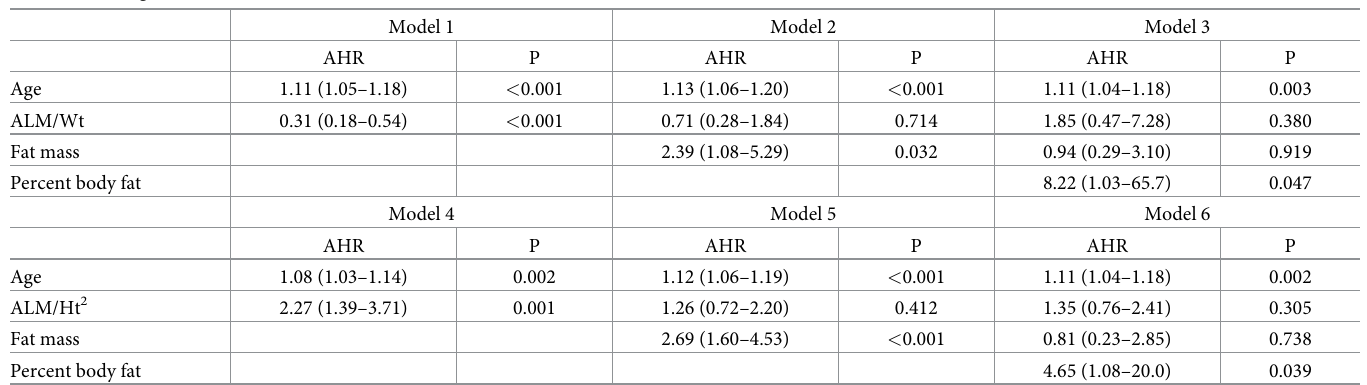
Table 5. Cox regression models of ALM and fat mass for MetS